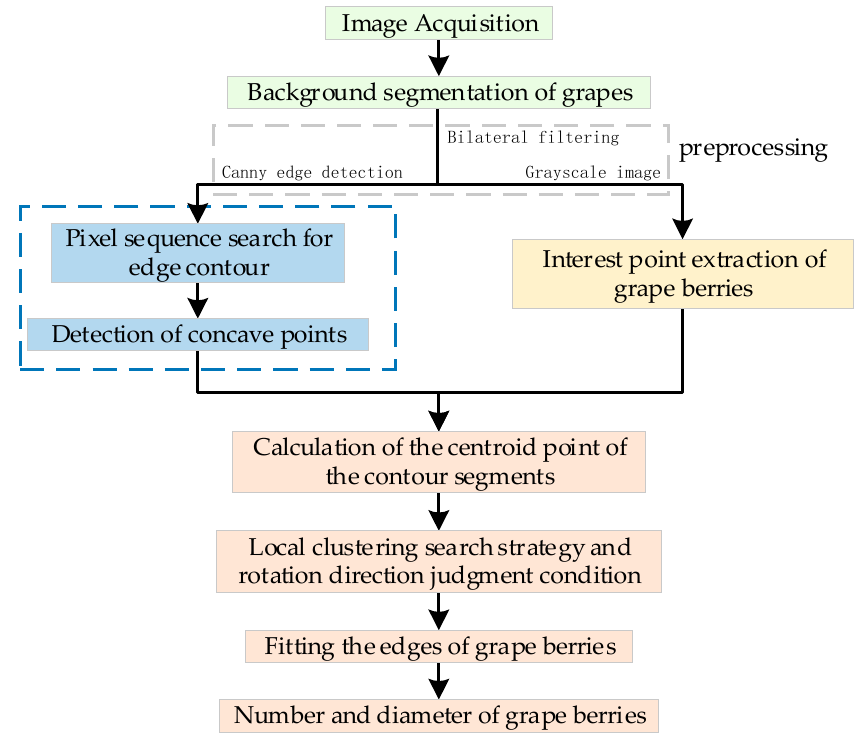
Figure 1. Detection algorithm framework of grape berries.